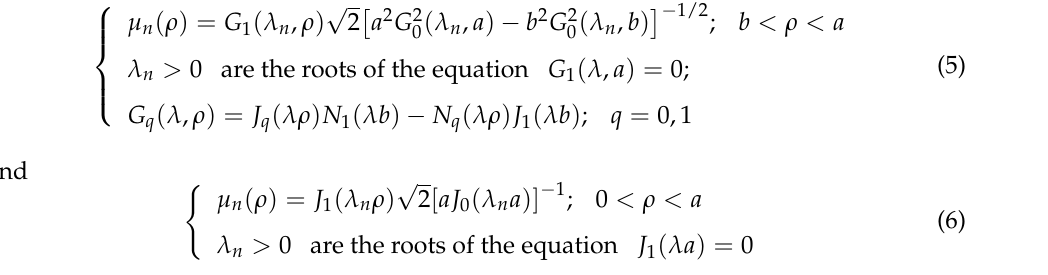
- pulse waveguide wave; and are its space–time amplitude and